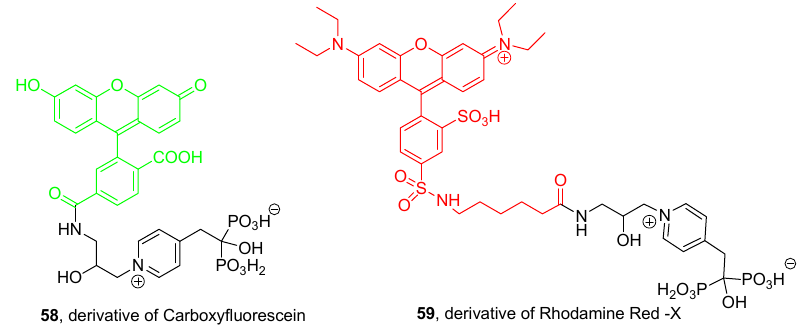
Scheme 29. Representative fluorescent imaging probes obtained via acylation of bisphosphonic acids (green—carboxyfluoresceine fragment, red—rhodamine Red-X fragment).